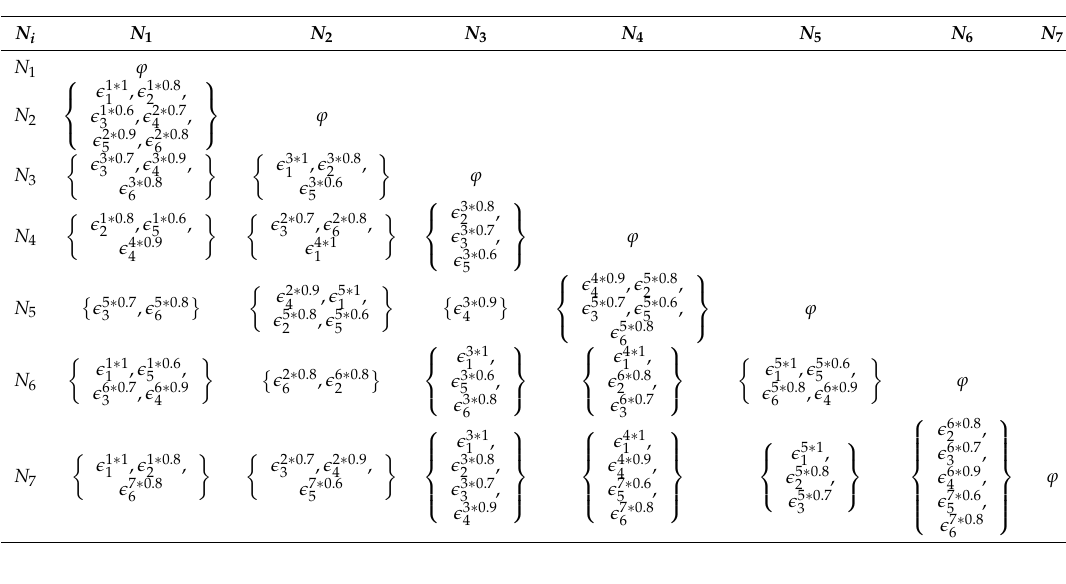
Table 13. The WSDM of case study in Section